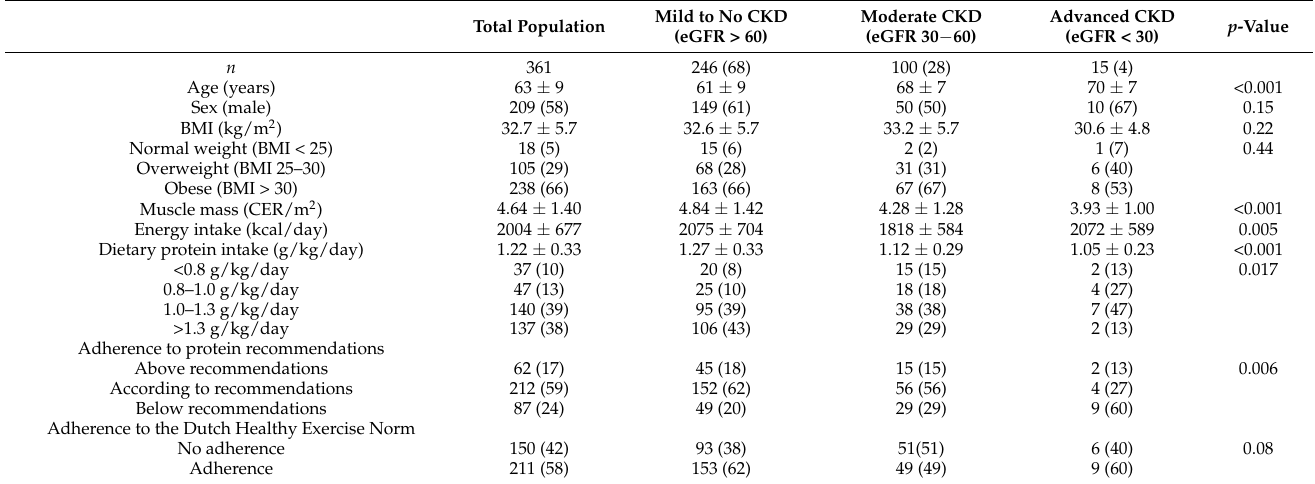
Table 1. Baseline patient characteristics by categories of chronic kidney disease of 361 patients with type 2 diabetes in the Diabetes and Lifestyle Cohort Twente.